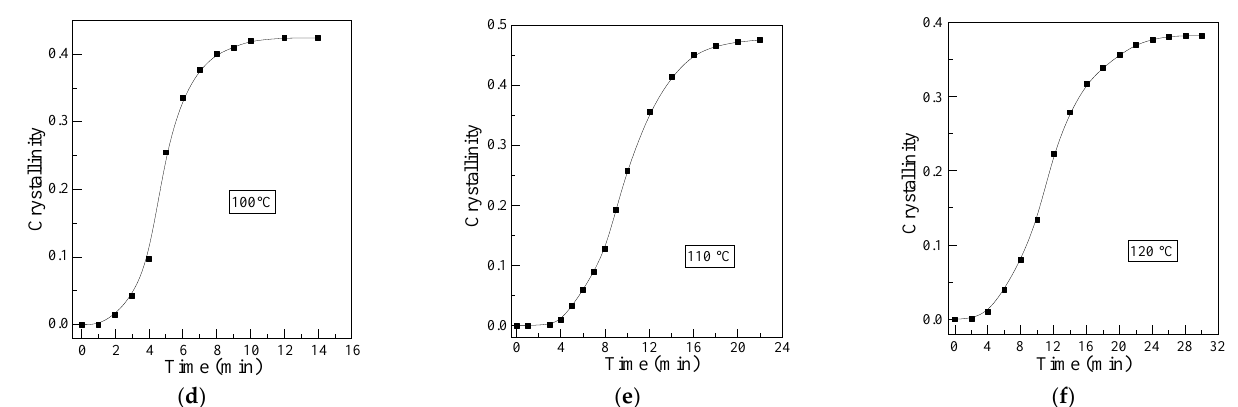
Figure 6. WAXD diffraction patterns of PLLA isothermally crystallized for various time at ( a ) 100 °C; ( b ) 110 °C; ( c ) 120 °C; and ( d – f ) are the crystallinity of PLLA calculated from ( a – c ), respectively, with crystallization time.